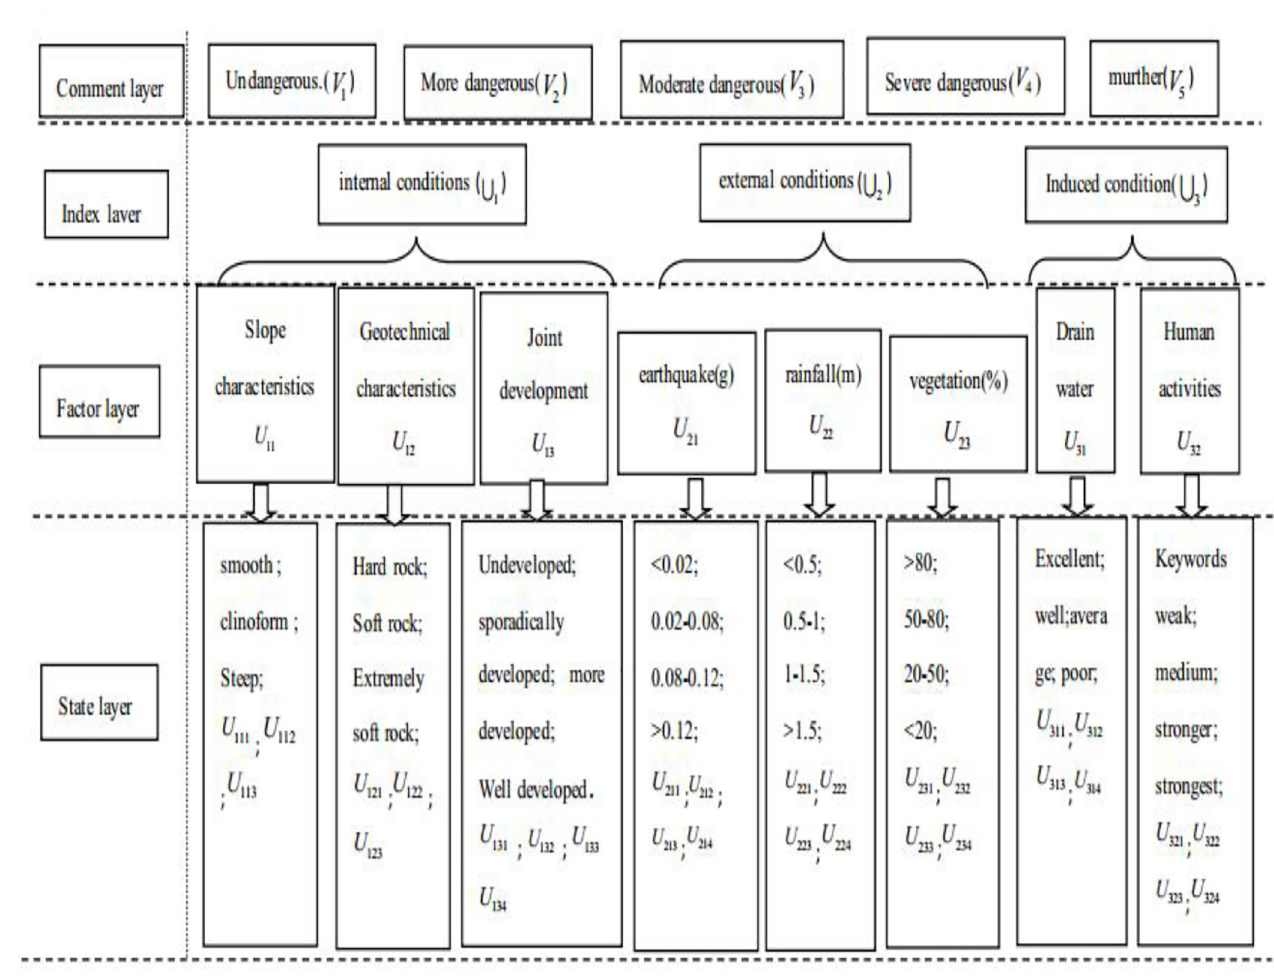
Fig 1. Multilevel index system for landslide hazard assessment.